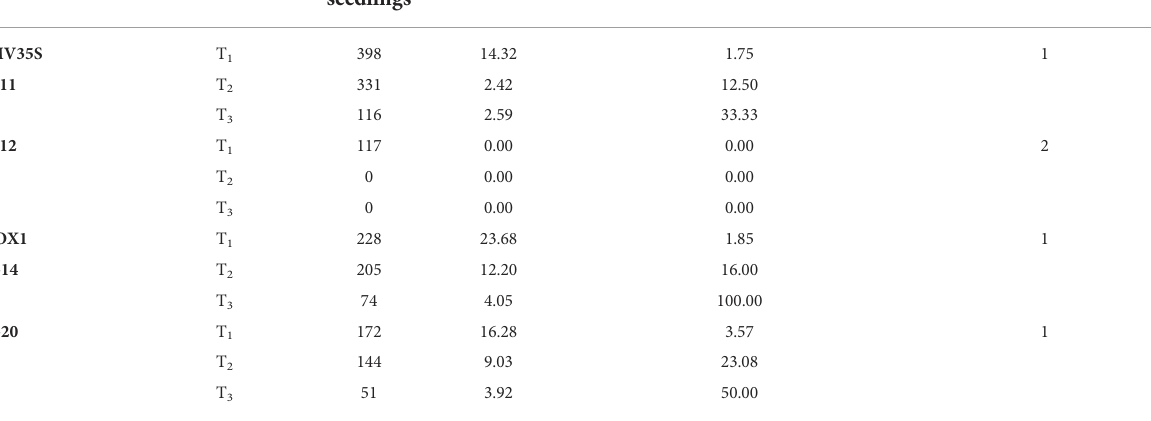
TABLE 1 The genetic inheritance of transgenes ( ipt ) in T 1 , T 2 and T 3 generations of transgenic P. pellucida plants obtained from two different promoters as c-11 and c-12 (driven by CaMV35S promoter), k-14 and k-20 (driven by KNOX1 promoter). Transgenic lines Transgenic seeds